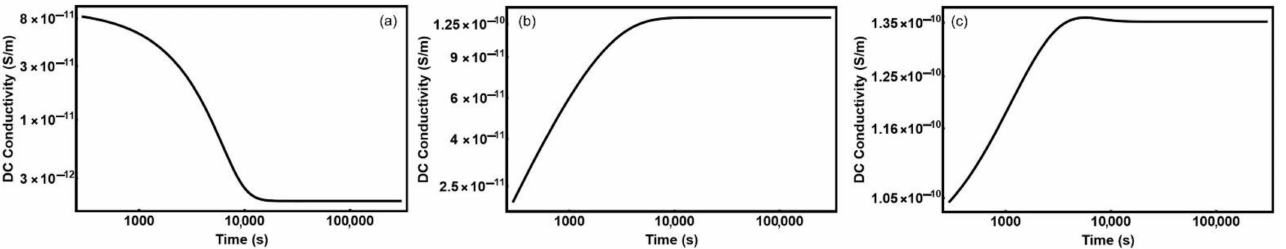
Figure 2. Time-dependent DC conductivity of liquid crystal cells. The cell thickness is 1 µ m. ( a ) Time dependence of DC conductivity caused by the ion-capturing effect (ions already present in liquid crystals are captured by the substrates of the cell). ( b ) Time dependence of DC conductivity due to the ion-releasing effect (ionic contaminants originated from contaminated substrates of the cell enrich liquid crystals with ions). ( c ) Time dependence of DC conductivity caused by the combination of the ion-capturing and ion-releasing processes shown in ( a , b ).